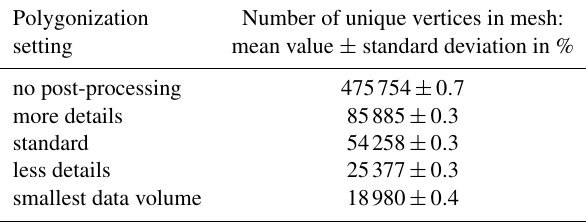
Figure 7. Visualization of the expanded measurement uncertainty ( k = 2) of gear wheel ID DG . Table 2. Statistical overview of the number of vertices of the dif- ferent triangle meshes for measurement series ID DG . The number of vertices (sampling points SP k ) of the used reference geometry is